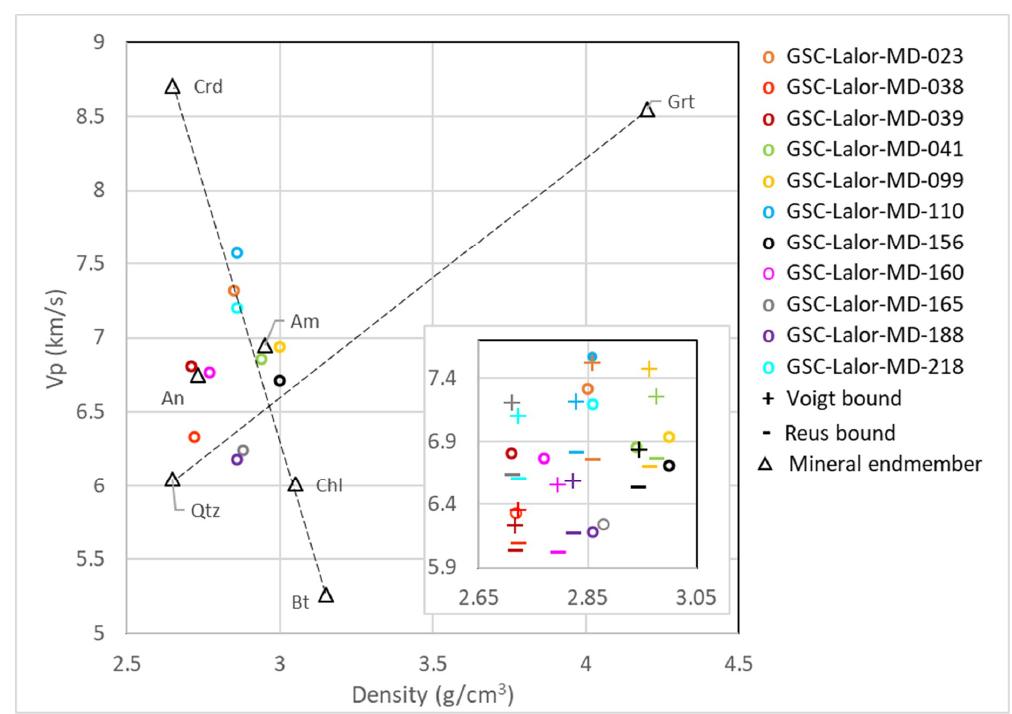
Figure 7. Plot of the seismic rock properties from the mixture modeling and endmembers (triangles) from the literature, corresponding to the minerals listed in Table 4. The inset shows mixture modeling estimates together with their modeled density-Voight (+) and Reuss (−) P-wave velocity bounds.